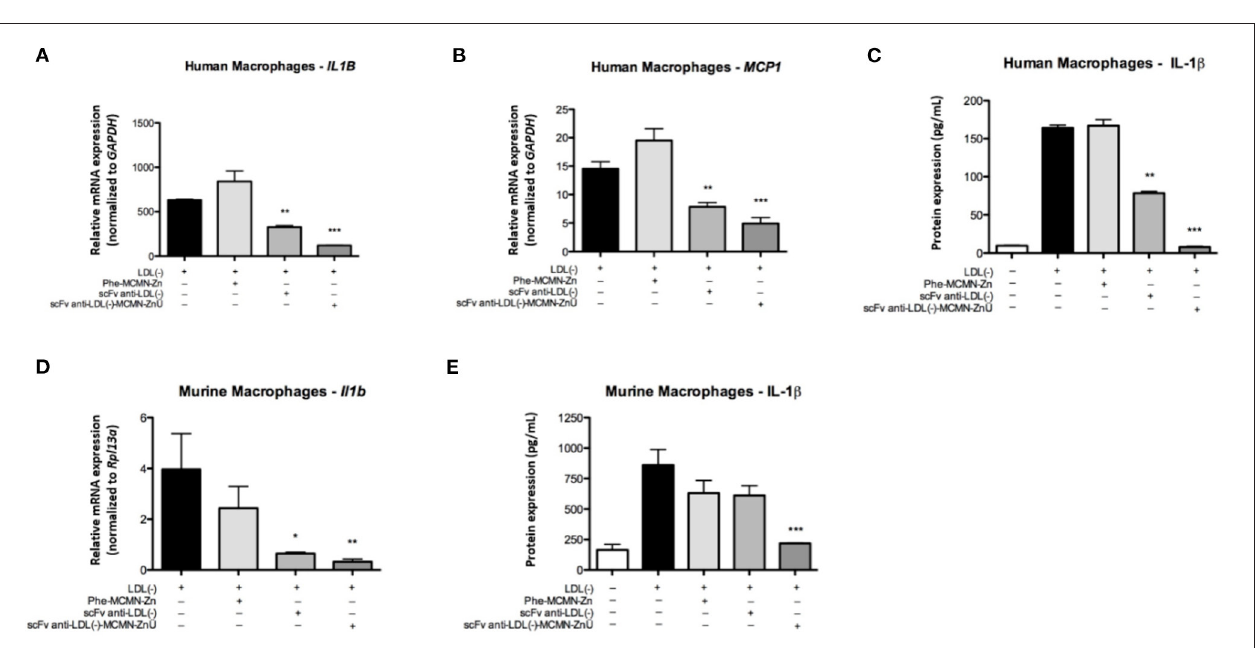
volume-weighted mean diameter and the highest polydispersity lowest concentration of chitosan (5 mg/mL) suggested that the surface coating of the nanocapsules was not